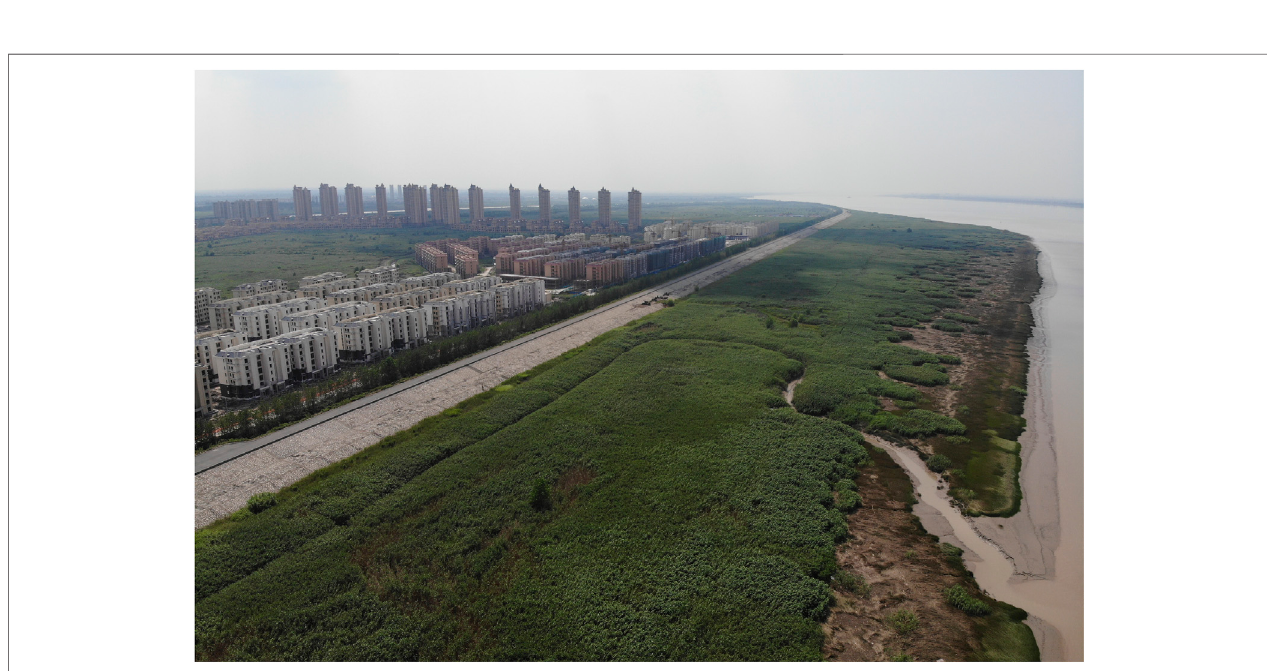
Frontiers in Environmental Science |